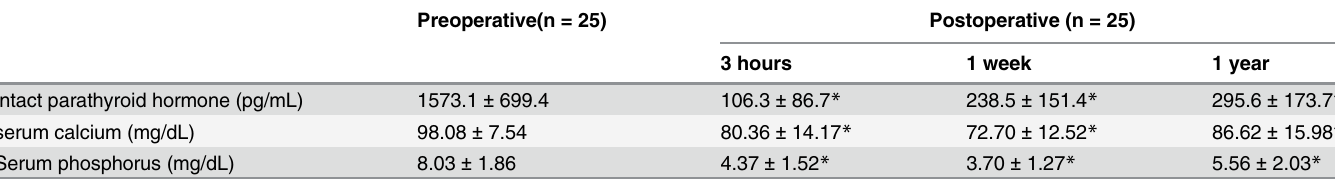
Table 2. Preoperative and postoperative biochemical values for dialysis patients following